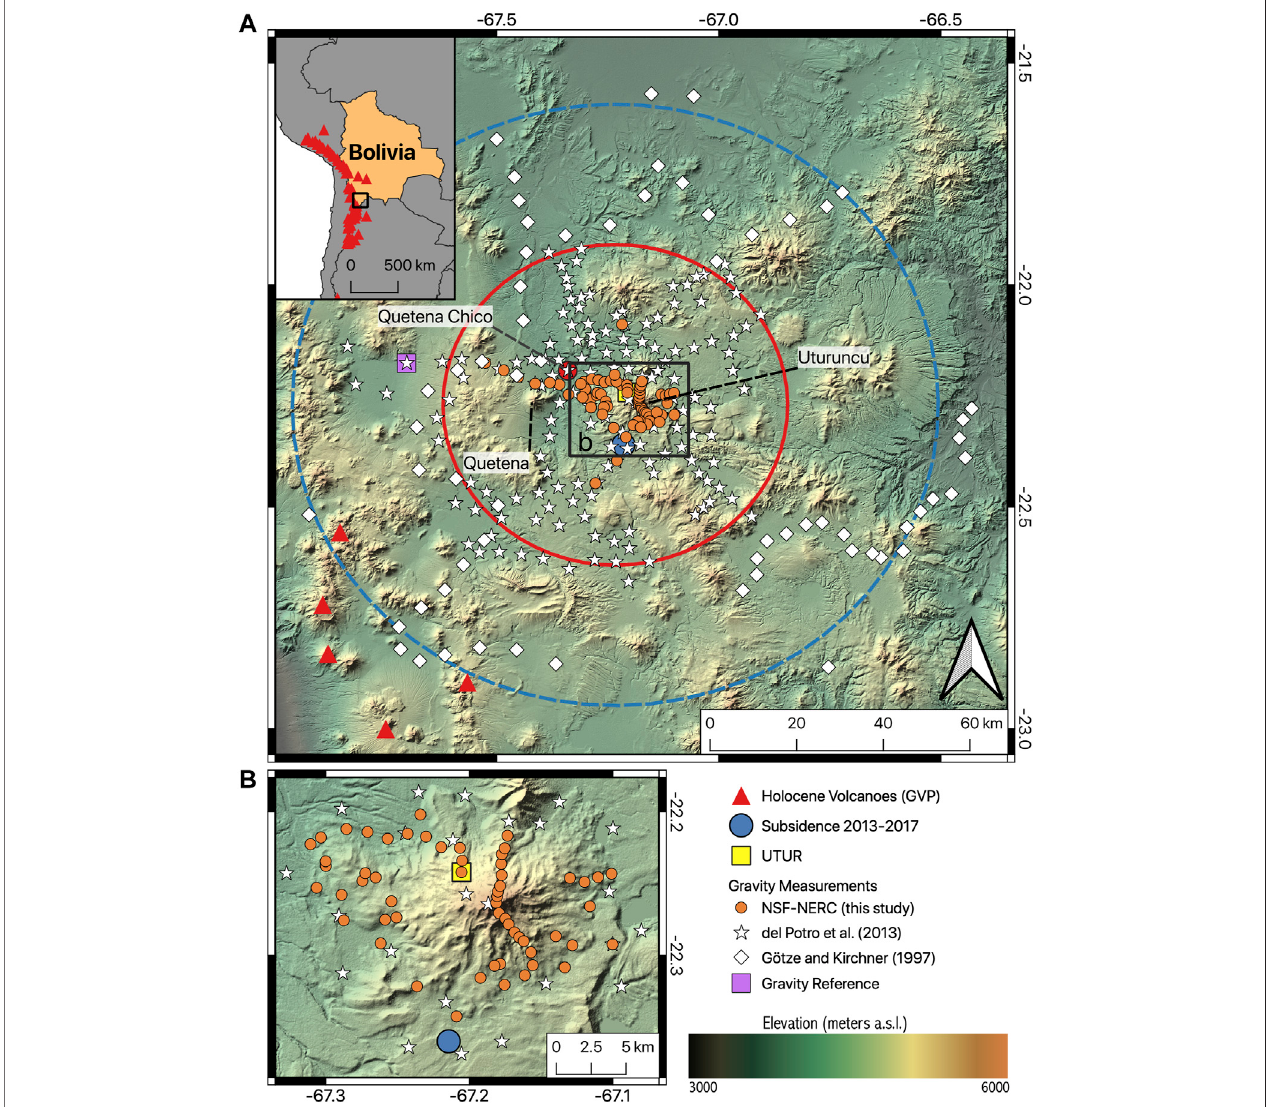
FIGURE 1 | Overview map of Uturuncu and surroundings with inset map showing the study area relative to Bolivia and South America. The gravity measurements from 2018 are marked with orange circles. Measurement locations from older surveys are marked with white symbols, and the gravity reference is marked by a purple square. The large red and blue circles denote the areas of approximately radial uplift and subsidence, respectively, (Pritchard and Simons, 2004; Fialko and Pearse, 2012; Henderson and Pritchard, 2013). The small solid blue circle marks the subsidence area south of Uturuncu identi fi ed by Lau et al. (2018) and Eiden et al. (2020). The black rectangle in (A) shows the extent of the map in (B) that highlights the locations of the 2018 measurements on the edi fi ce of Uturuncu. Digital elevation map (DEM) from (NASA/METI/AIST/Japan Spacesystems and U.S./Japan ASTER Science Team, 2019). The red stars are the locations of Holocene volcanoes (Global Volcanism Program, 2013) and the yellow square is the continuous GNSS station UTUR (Henderson and Pritchard, 2017).